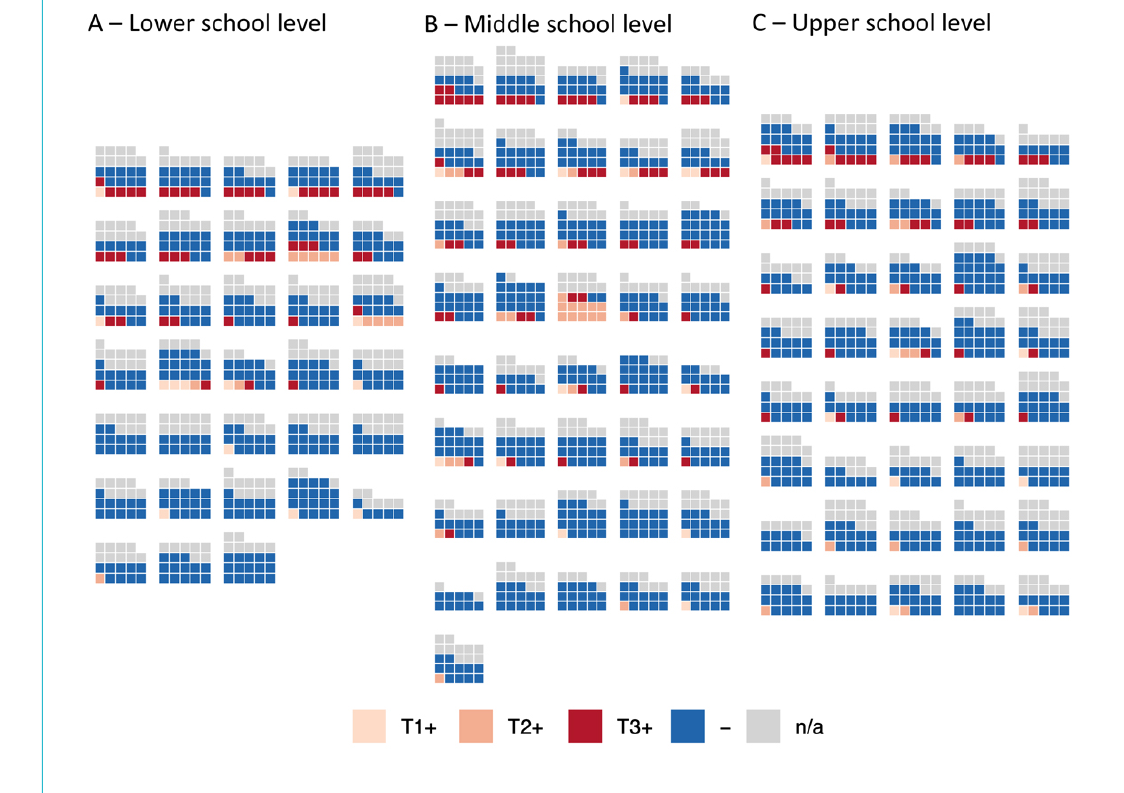
Figure 5: Distribution of children who were seropositive at T1, T2 and T3 in classes with high participation rate at T3. Each block of squares represents a class. High participation rate means that at least 5 children were eligible and at least 50% children were tested in the class. T1+ (light pink) – children who tested seropositive at T1 (June-July 2020), T2+ (middle orange) – children who tested seropositive at T2 (October- November 2020) but not T1, T3+ (dark red) – children who tested seropositive at T3 (March-April 2021) but not at T1 or T2, - (dark blue) – children who tested seronegative at T3 and were not test seropositive previously, n/a (grey) – children without a serological result at